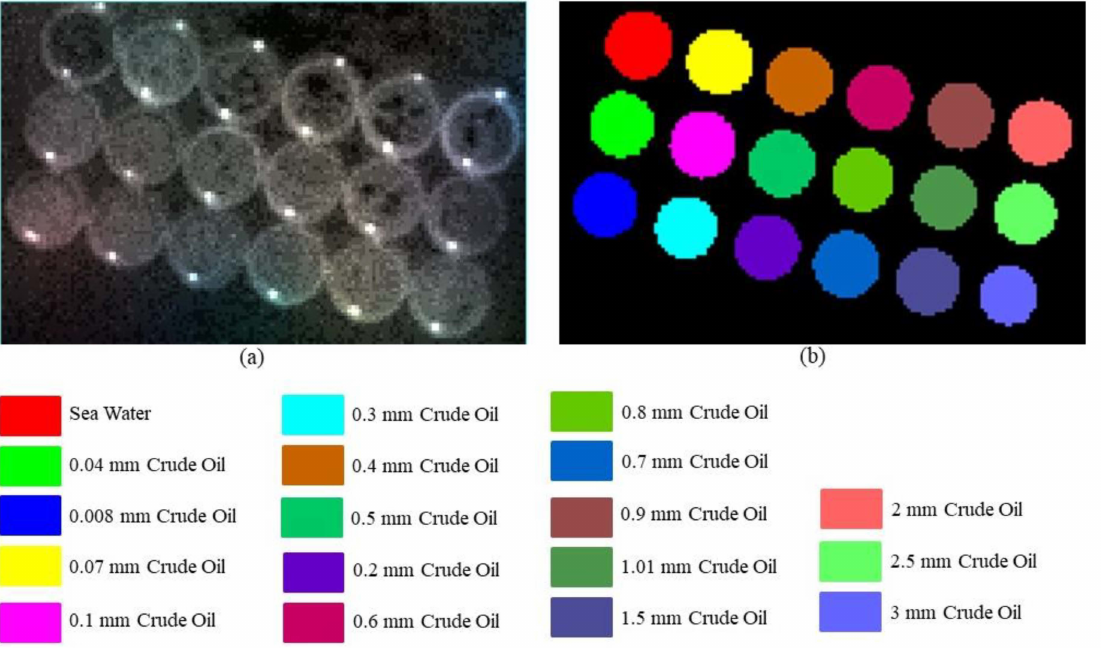
Figure 3. Oil film thickness data: ( a ) False-color image (R: 11, G: 27, B: 45); ( b ) ground-truth